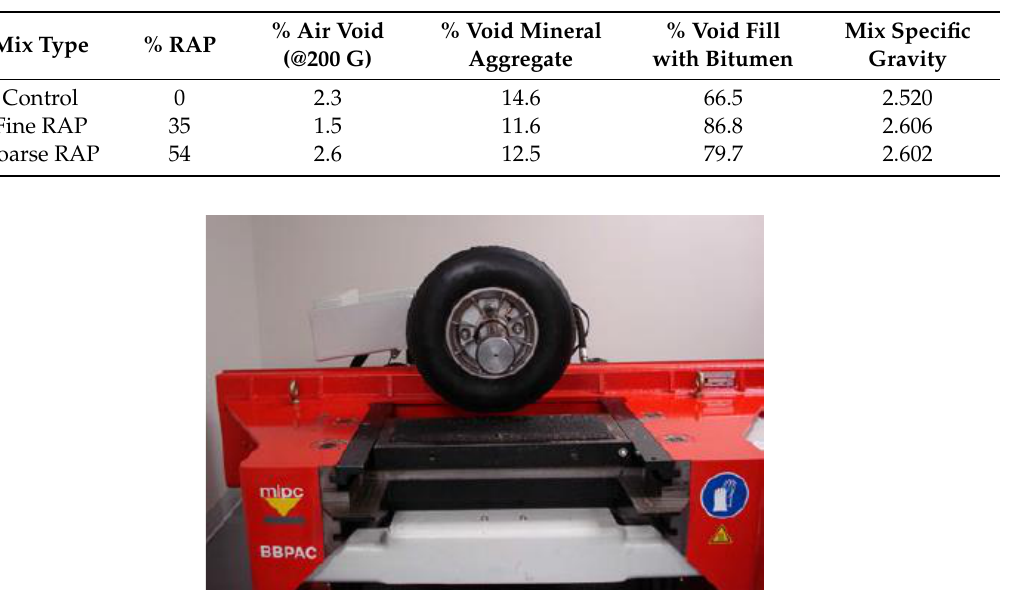
Table 2. The composition of control and experimental mixes.